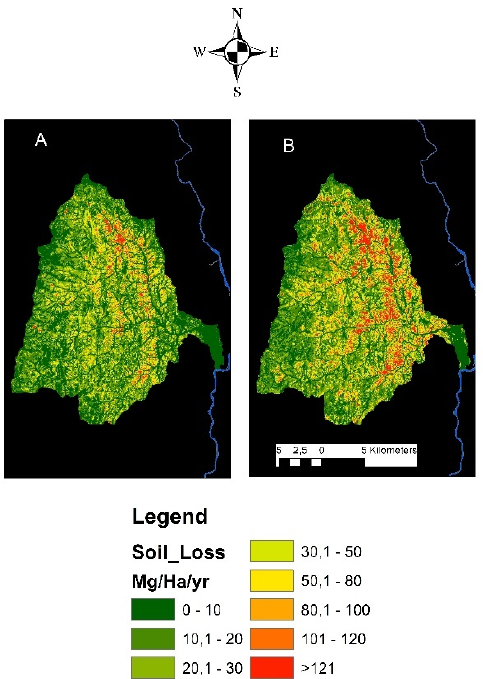
Figure 8. Comparison of the spatial distribution of the simulated average annual potential soil loss in the Tonusco River basin between the years 1997 ( A ) and 2015 ( B.